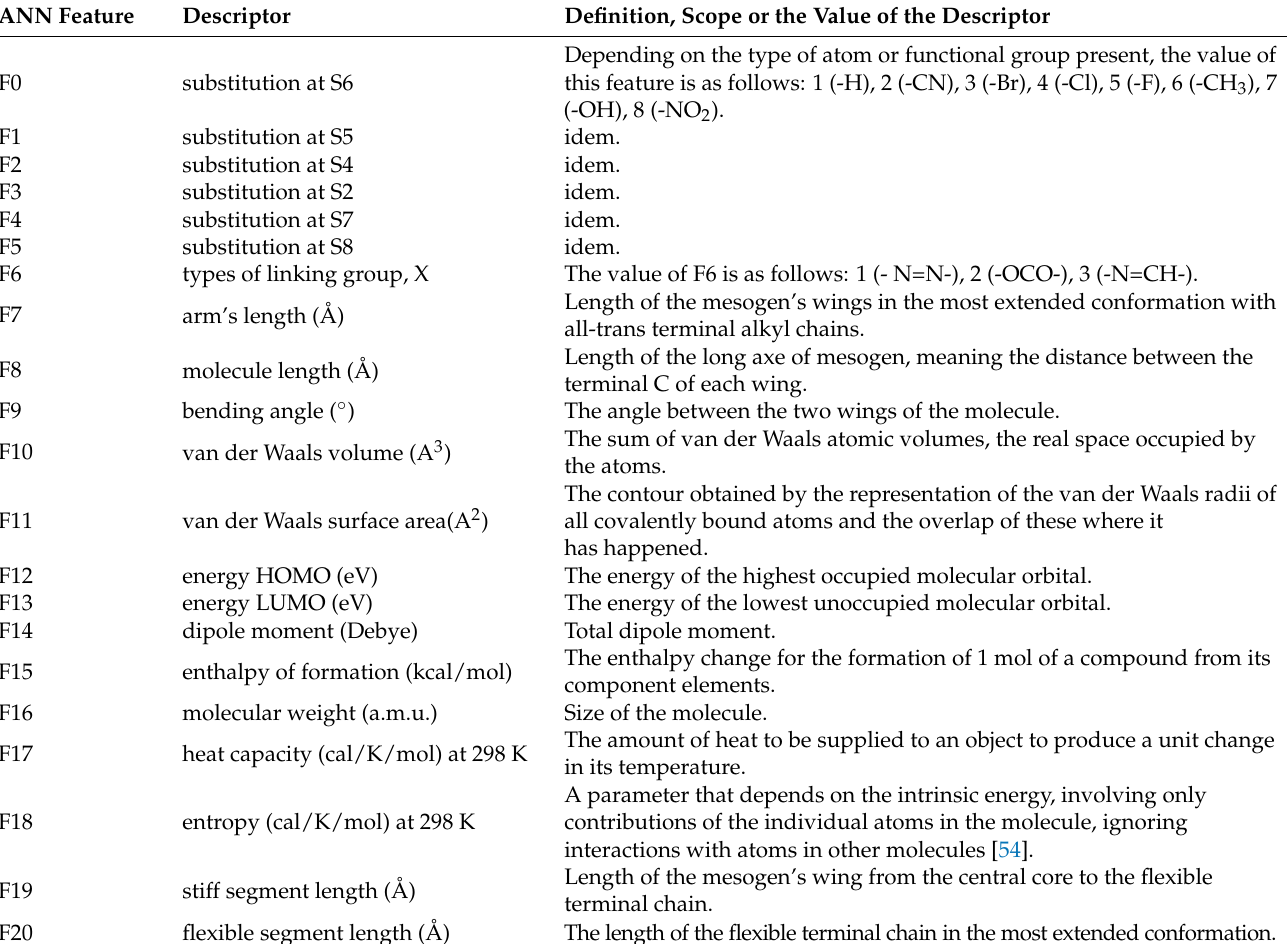
Table 1. List of the features included in ANN with the type of descriptor and a short